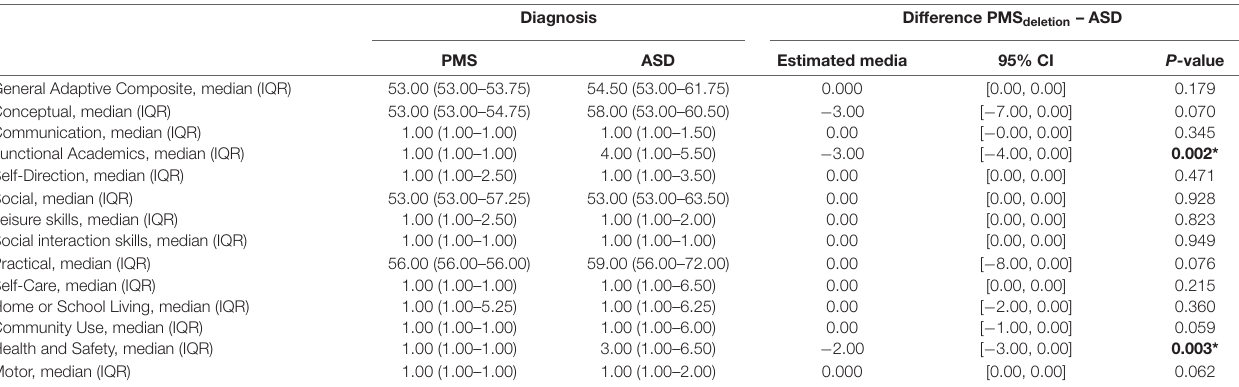
TABLE 3 | Descriptive statistics and comparative analysis of the ABAS-II in PMS and ASD